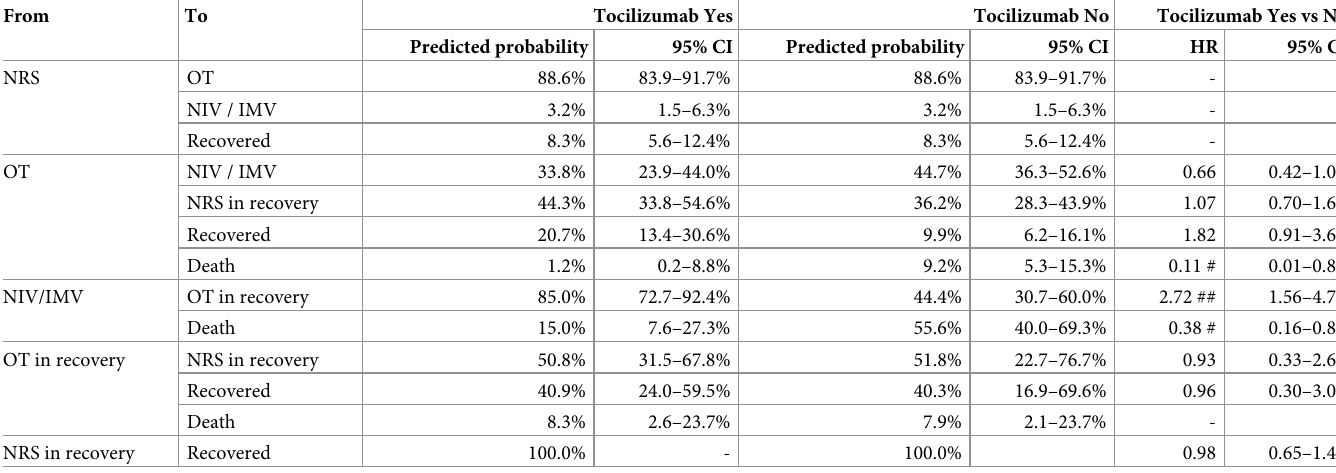
Table 2. Unadjusted effect of tocilizumab use on change of state risks. From To